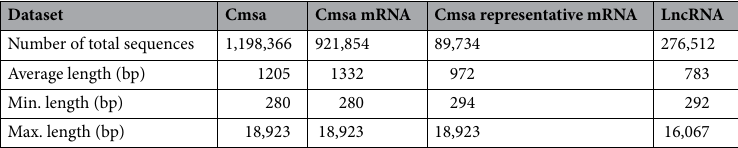
Table 3. Summary of Cmsa dataset.